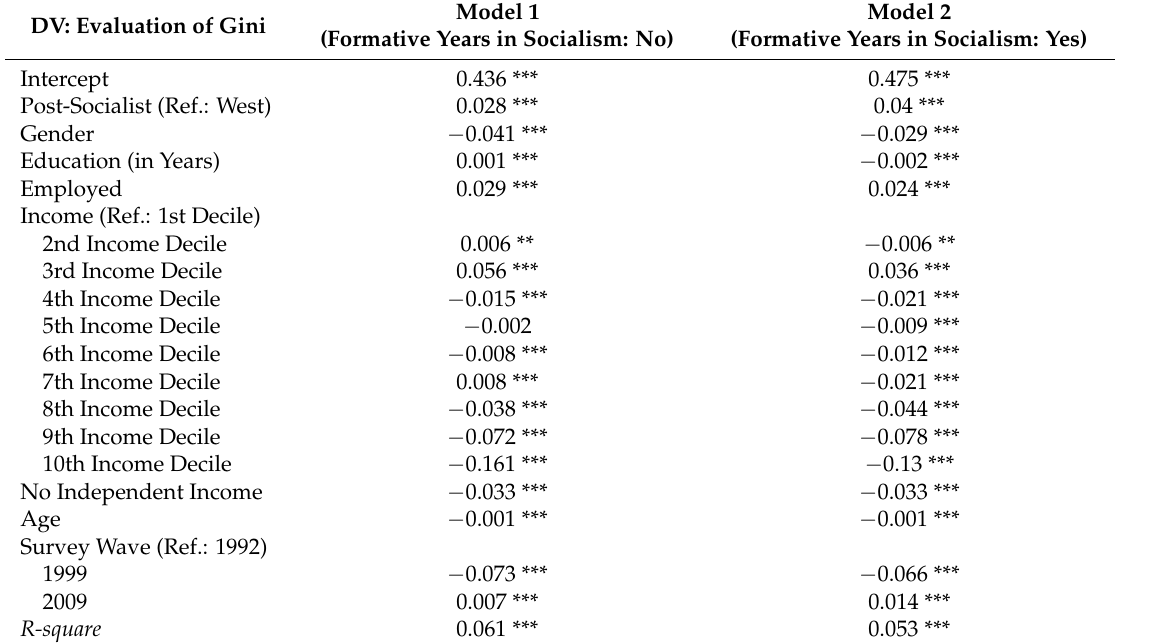
Table A4. Bootstrapped OLS regression models to explain the evaluation of Gini by formative years (corresponding with Figure 2a). Model 1 Model DV: Evaluation of Gini (Formative Years in Socialism: No)